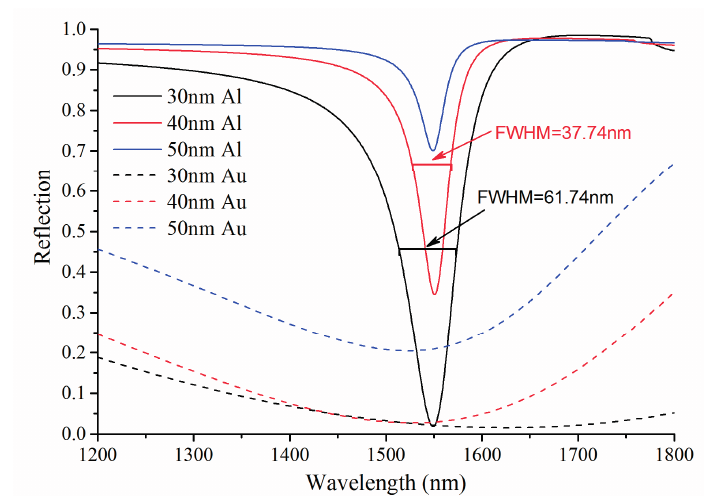
Figure 6. The single metallic SPR curve of wavelength interrogation for different thickness of the metal (Au or Al) layer at resonance angle from Figure 5 and the refractive index of the analyte solution n a = 1.33.